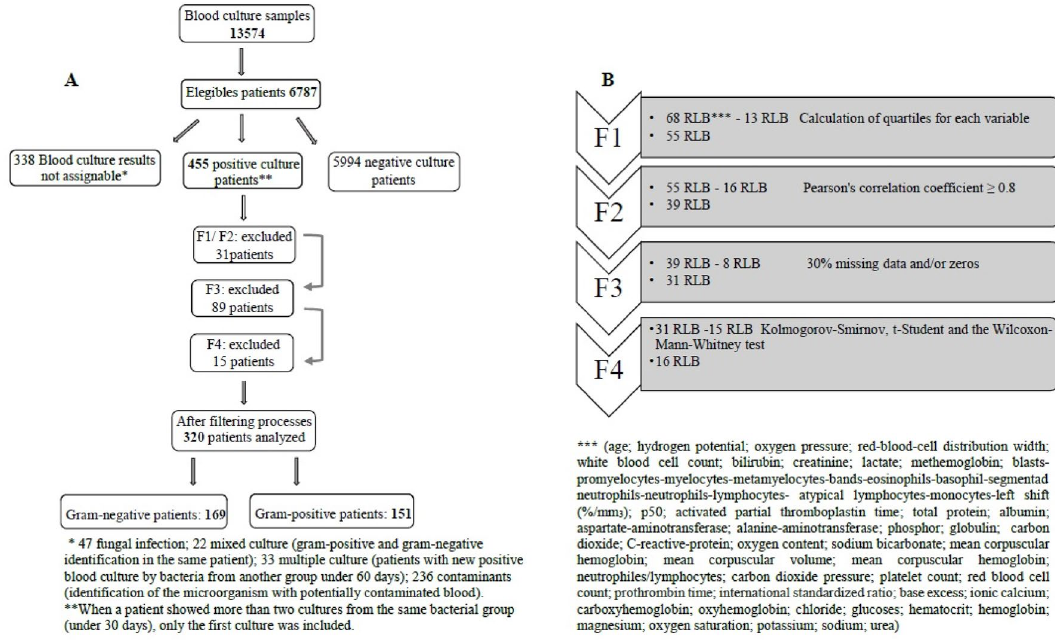
Figure 1. ( A ) Criterium for exclusion of patients; ( B ) exclusion criterium for routine laboratory biomarkers (RLB). F1 = first filtering process variables with different quartiles were kept in the bank at 0%, 25%, 50%, 75% and 100%. F2 = second filtering process, Pearson’s correlation coefficient of 0.8 in absolute value was adopted as the cutoff. F3 = third filtering process, variables with 30% or more of lost values and/or zeros were removed. F4 = fourth filtering process, The Kolmogorov–Smirnov tests, the t-Student test and the Wilcoxon-Mann– Whitney test were used and variables with p ≤ 0.1 in at least one of the tests were